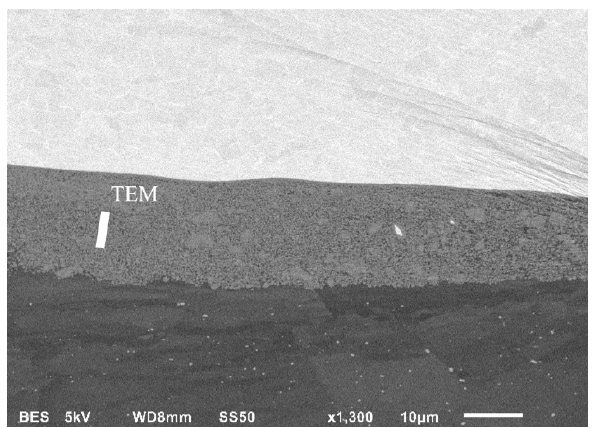
Figure 17. SEM image of the microstructure of AA1050/Ti6Al4V joint hot-rolled at 400 °C.